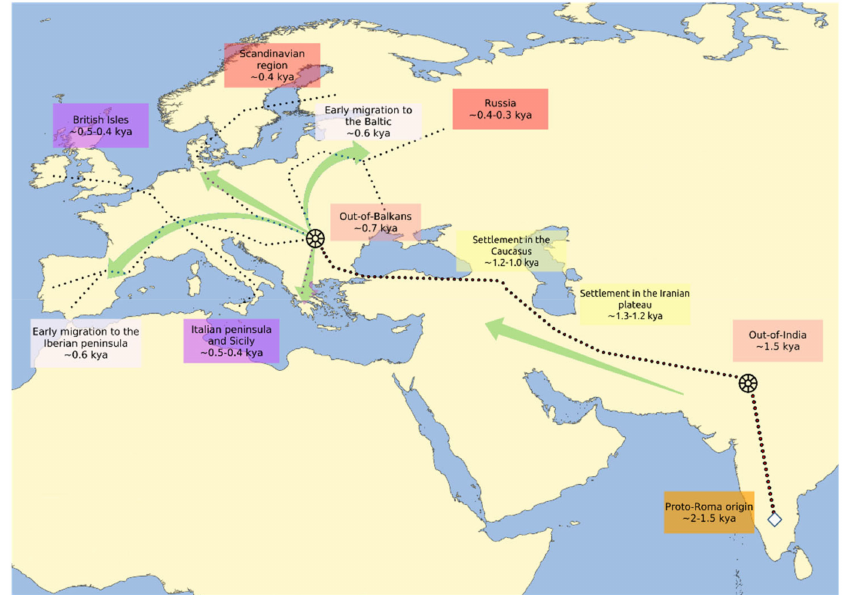
Figure 1. Early routes of the Romani diaspora. The figure is based on data from Kenrick 2007, Mendizabal et al., 2012, Moorjani et al., 2013, Font-Porterias et al., 2019 and Bianco et al., 2020, and reports the estimated date of arrival and settlement of the Romani populations in different regions of West Eurasia. The wheel symbols indicate the two main reported bottlenecks experienced by the Roma, the arrows indicate the main flow of the migrations and the dotted lines indicate the possible routes of the